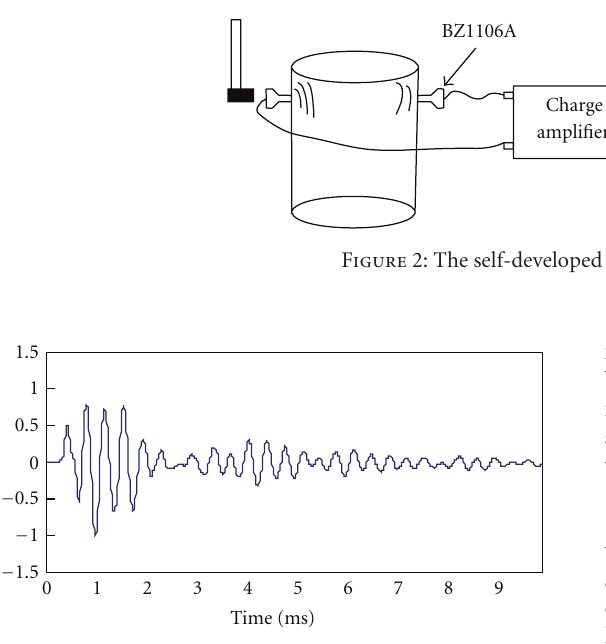
Figure 3: A typical stress wave signal used in this study.